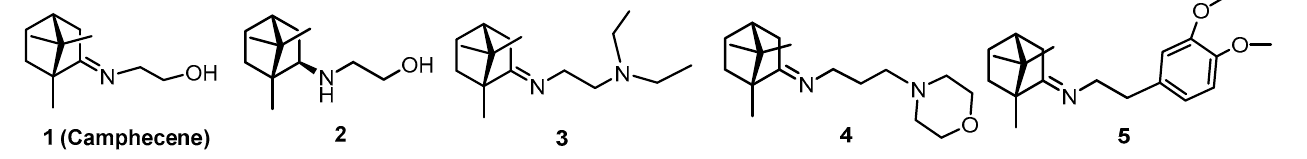
Figure 3. First class compounds—camphor derivatives.